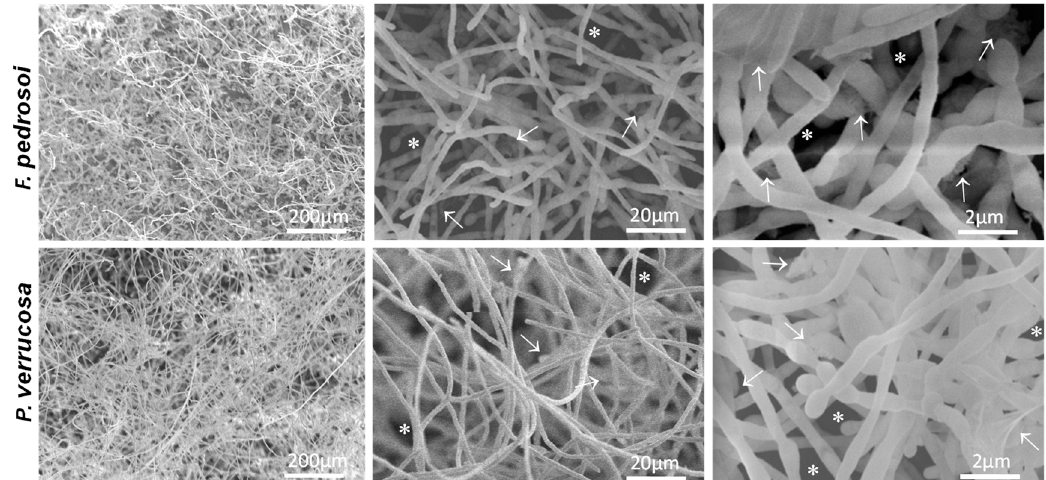
Figure 5. Low-magnification SEM images of fungal biofilm on a polystyrene surface. Fungal cells (1 × 10 6 ) were added to polystyrene cover slips and incubated for 72 h at 37 °C. Then, the cells were processed for SEM, as detailed in Material and Methods. Representative images of F. pedrosoi and P. verrucosa showed biofilm features as dense masses of mycelia containing inner water channels (asterisks) and extracellular matrix (white arrows).